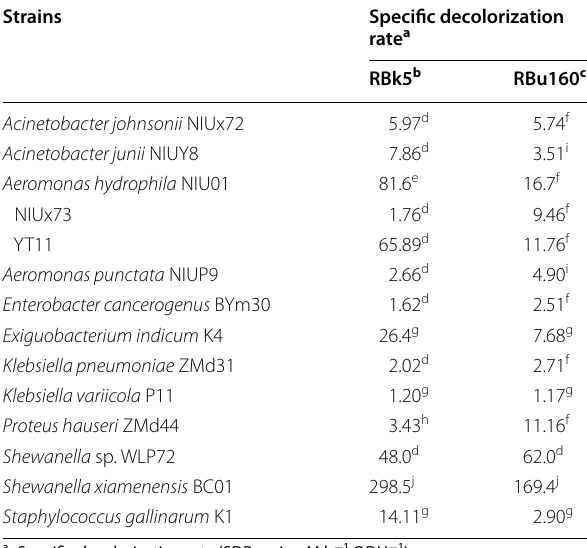
Table 3 Comparisons between Proteus hauseri and other decolorizers on the efficiencies of decolorizations. Cited from Hsueh et al. (2017)